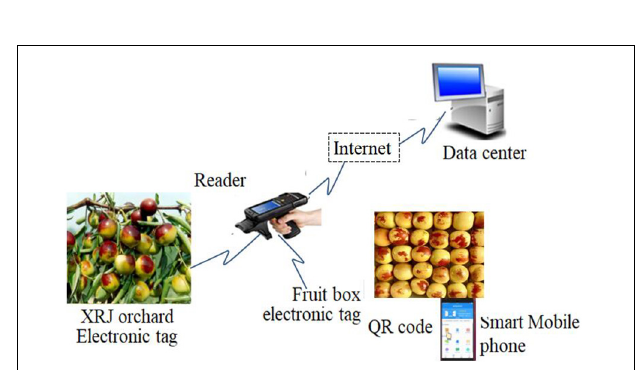
FIGURE 2 | XRJ tracing query based on radiofrequency identification (RFID) + Quick Response (QR)